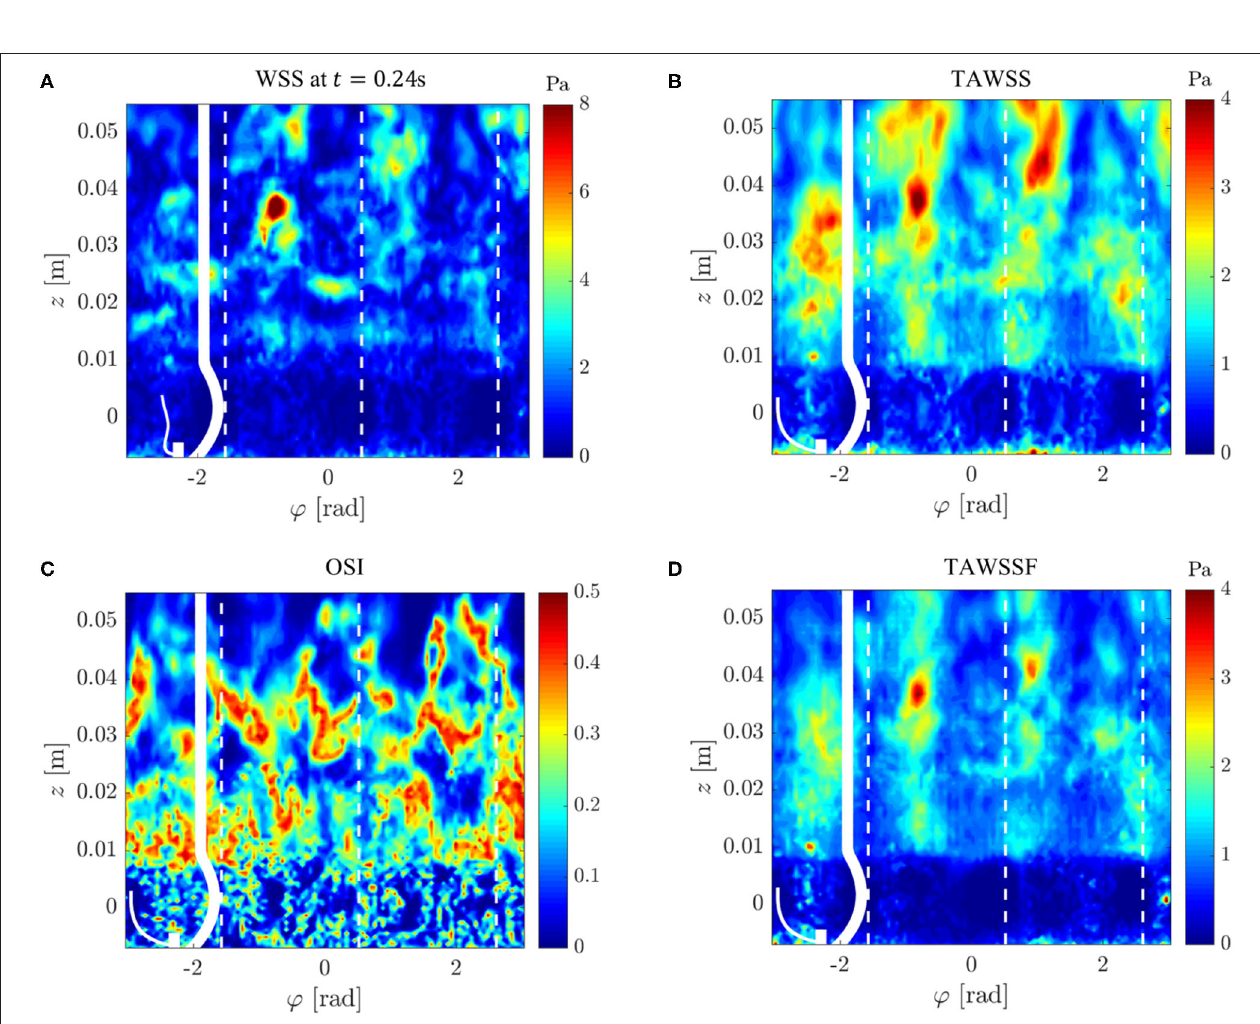
FIGURE 14 | Wall shear stresses on the AR wall: (A) instantaneous WSS at t = 0.24s, (B) mean WSS, (C) oscillating shear index OSI, (D) mean magnitude of WSS fluctuations. The values were projected onto an unrolled cylinder surface where the vertical dashed lines highlight the azimuthal locations of the valve posts.